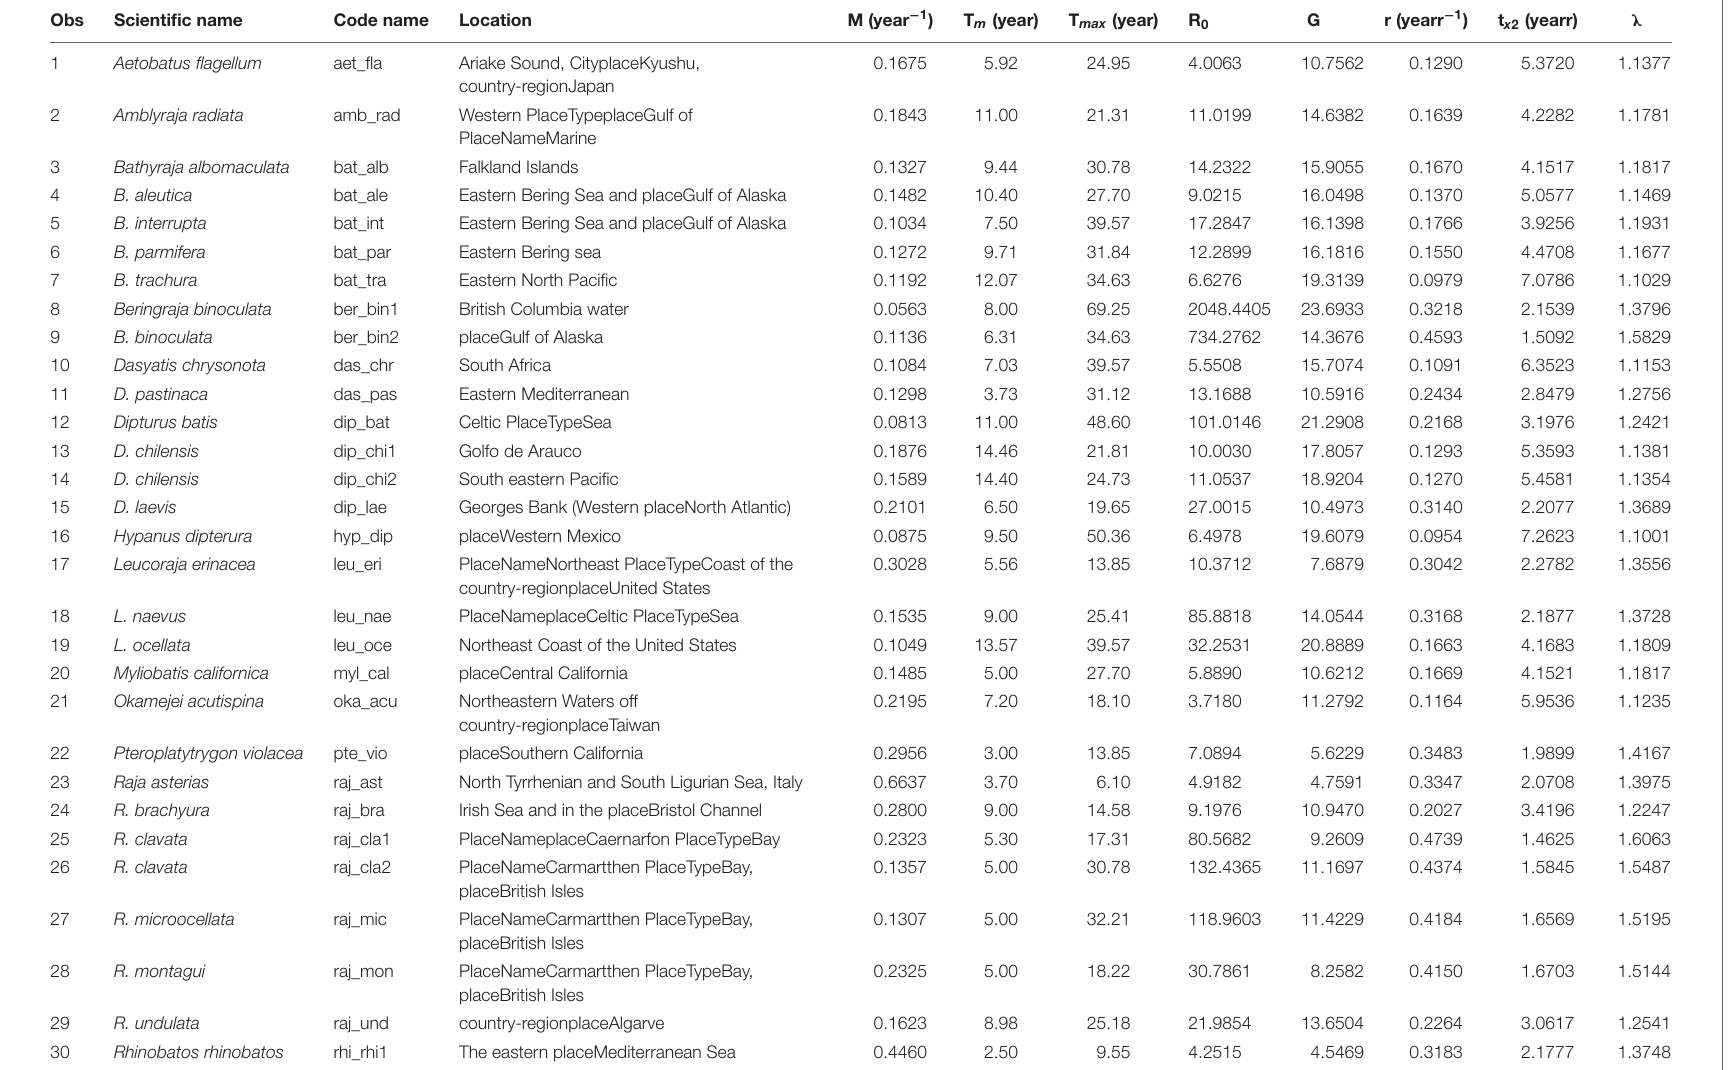
TABLE 1 | Estimated demographic parameters based on conventional demographic approach for the 41 stocks (35 species) of skates and rays.